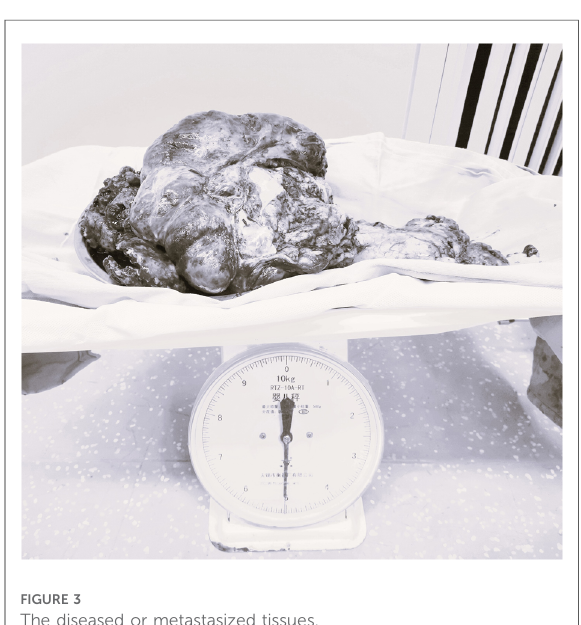
FIGURE 3 The diseased or metastasized